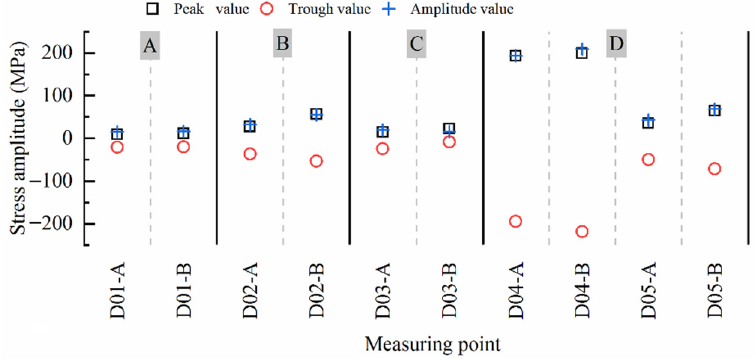
Figure 9. Measured stress amplitude.